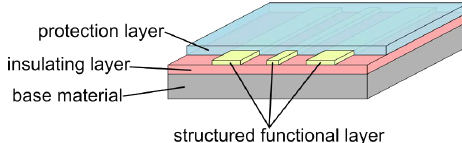
Figure 1. Film system used for the thin film sensors.